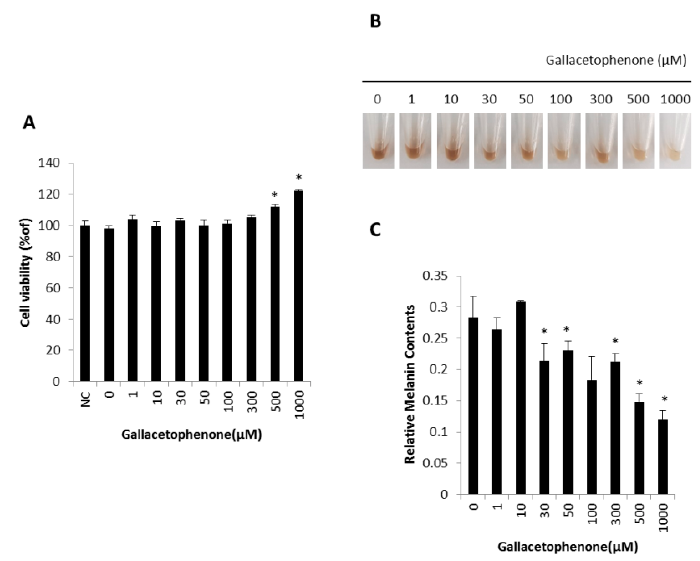
Figure 3. Anti-melanogenic effect of gallacetophenone in human epidermal melanocytes. ( A ) Cell viability after treatment with various concentrations of gallacetophenone; ( B ) the color of cell lysate; ( C ) the melanin content determined using cell lysates. Data are expressed as the mean ± SD of at least three independent measurements (* p <